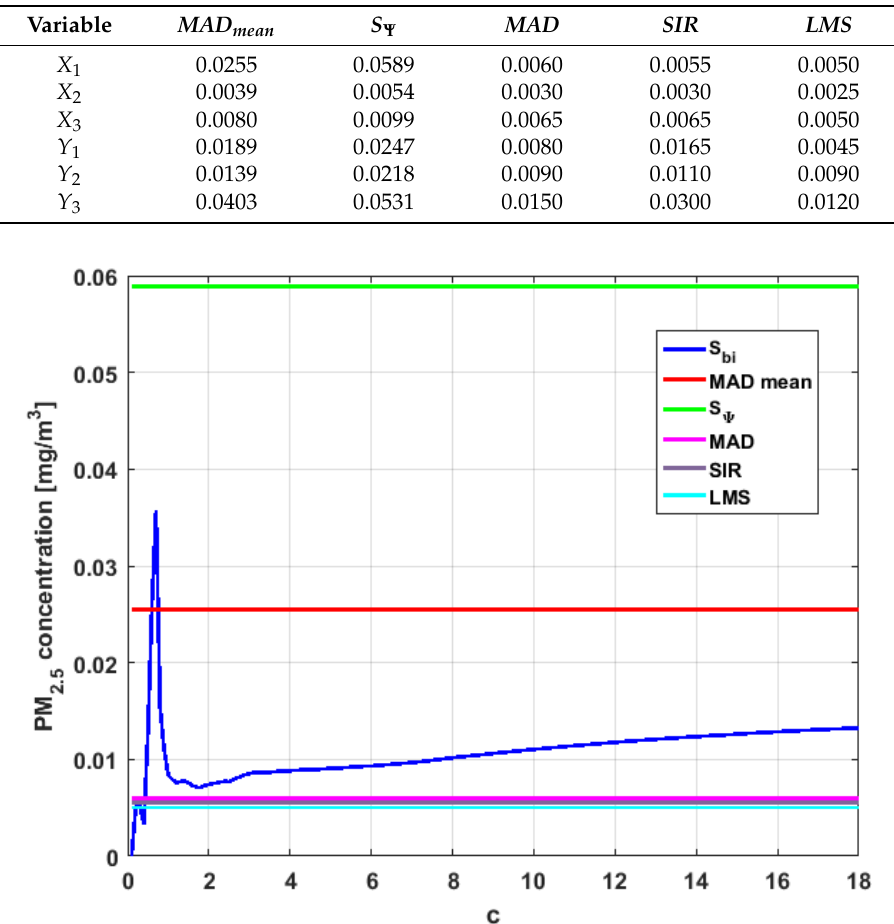
Table 4. Scale estimates.